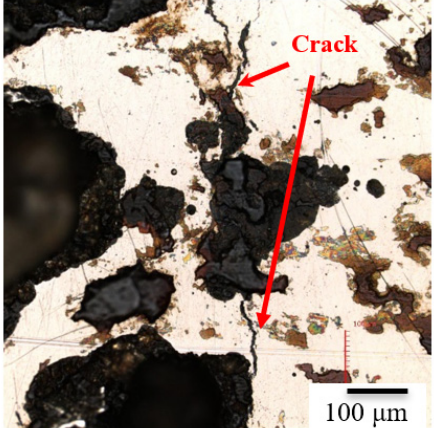
Figure 4. The round specimens with 1 g/m 2 of sea salt deposited on the surface were tested at different relative humidity levels of 45%, 55%, and 70%, and a temperature of 45 °C.